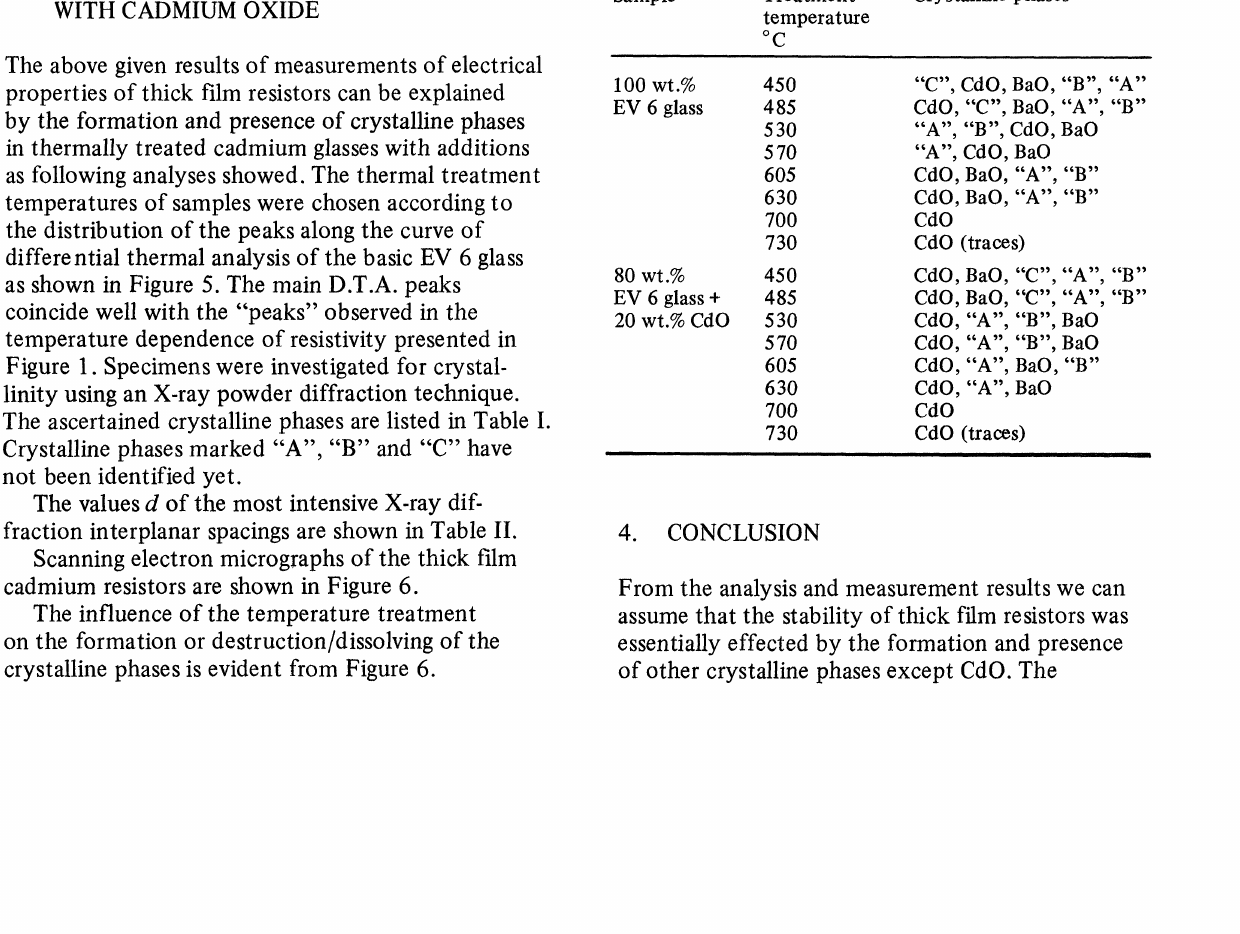
TABLE Crystalline phases in the thermally treated EV 6 glass and in the mixture of EV 6 glass with CdO addition.